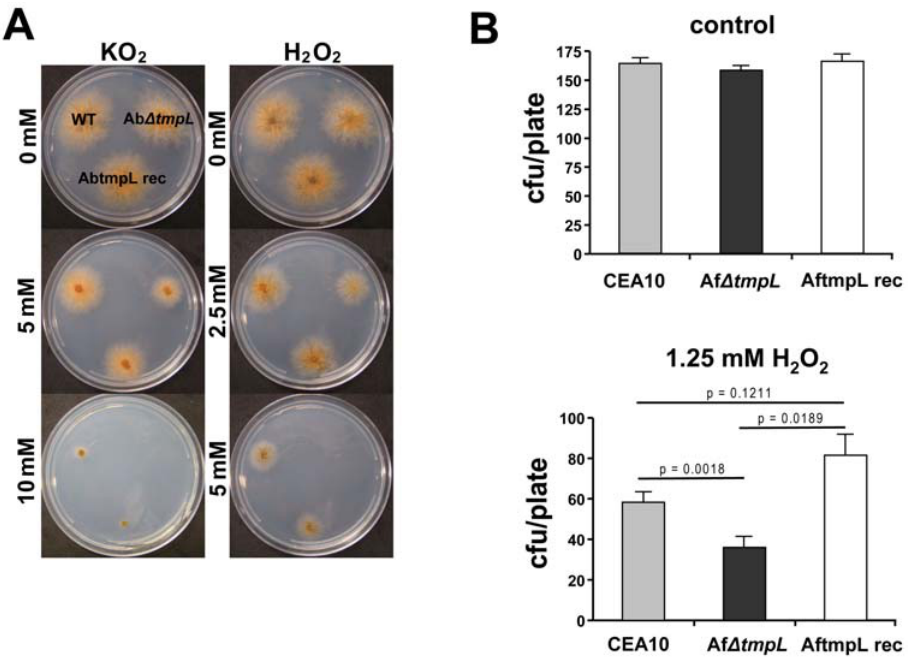
Figure 6. D tmpL mutants are hypersensitive to extracellular oxidative stress. ( A ) Increased sensitivity of A. brassicicola D tmpL mutants to oxidative stress generated by KO 2 or H 2 O 2 compared with wild-type. Conidial suspensions of A. brassicicola wild-type (WT), D tmpL mutant (Ab D tmpL ), and reconstituted strain (AbtmpL rec) were cultured on minimal agar medium containing different concentrations of KO 2 or H 2 O 2 and evaluated 5 days after inoculation. ( B ) Increased sensitivity of A. fumigatus D tmpL mutant germlings to oxidative stress generated by H 2 O 2 compared with wild- type. Plates with the germlings of A. fumigatus wild-type strain (CEA10), D tmpL mutant (Af D tmpL ), and reconstituted strain (AftmpL rec) were overlaid with 1.25mM H 2 O 2 solution, incubated at 37 u C for 10 minutes. After washing the plate with sterile distilled water the plates were incubated until colonies were large enough to count. Samples were prepared in triplicate, and error bars on the graph represent SD of two independent experiments.